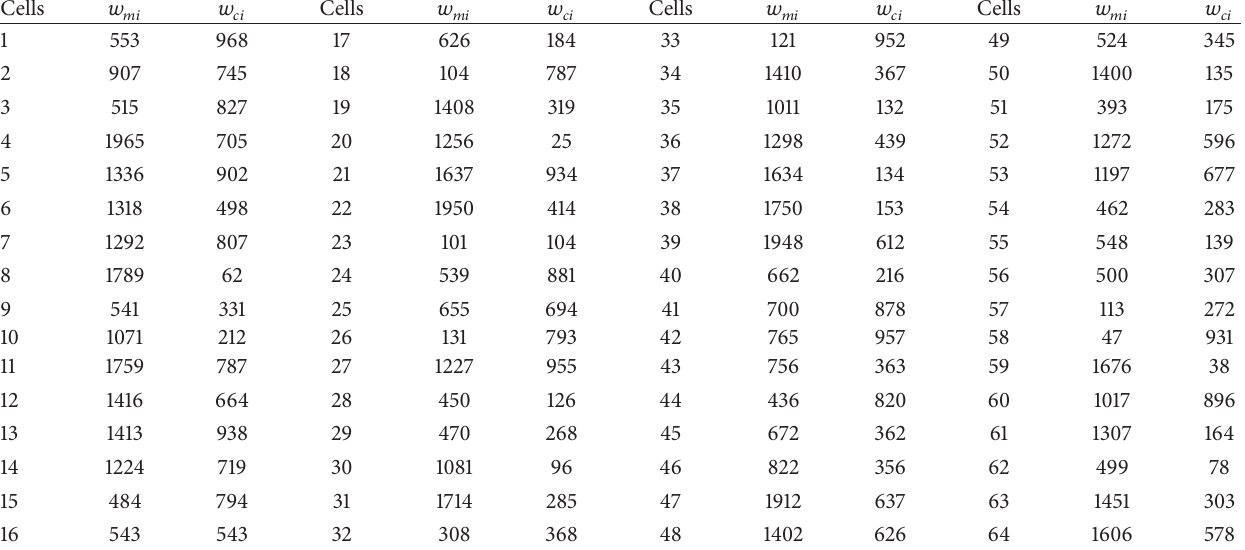
Table 5: Cells attribute for the 8 × 8 test network.